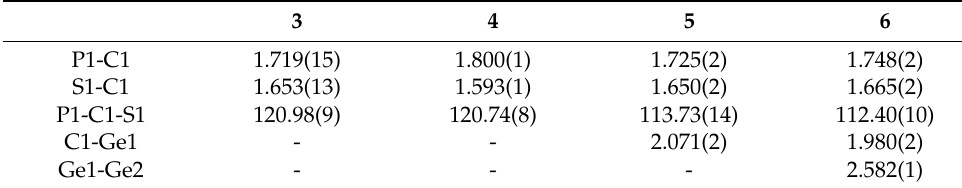
Table 1. Selected geometrical parameters for 3 , 4 , 5 and 6 1